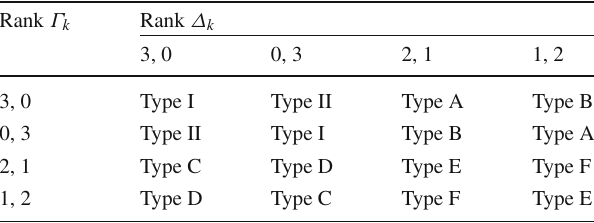
Table 3 Identification of the Right models (and the usual Types I and II), in terms of the ranks of the Yukawa matrices, in the order Δ 1 ,Δ 2 (in columns), and Γ 1 ,Γ 2 (in rows)